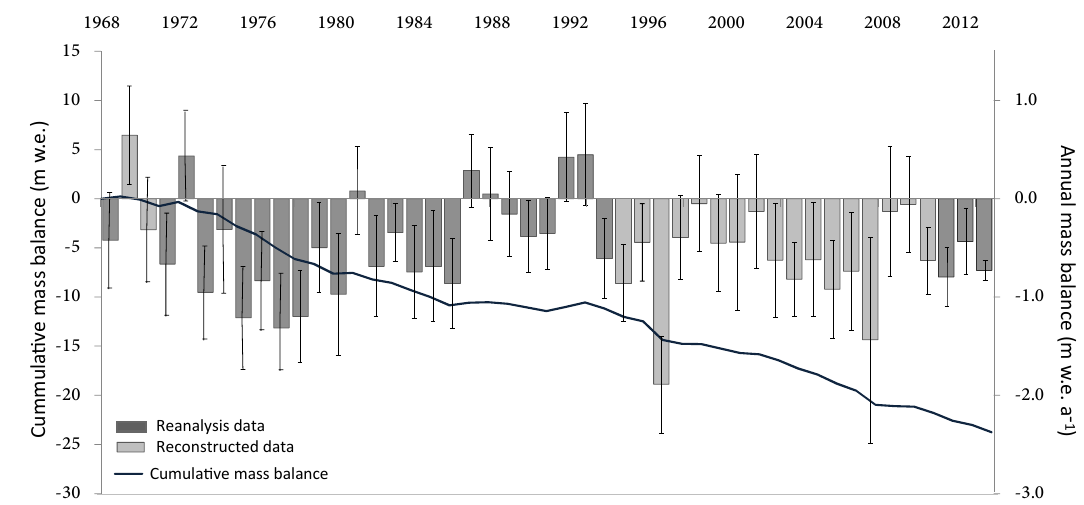
Figure 4. Reconstructed mass balance data for the Abramov glacier according to Barandun et al. (2015). Table 4. Observed geodetic mass balance for Abramov, Golubin, Batysh Sook and Glacier No. 354. B glac.-rec. refers to a study by Barandun et al. (2015), where the mass balance was reconstructed based on a calibrated model (see Sect. 3.3.6). Glacier Method Source Period B a Abramov B glac.-rec. Barandun et al. (2015) − 0 . 51 ± 0 . 15 Abramov B geod. Gardelle et al. (2013) − 0 . 03 ± 0 . 14 Golubin B geod. Golubin B geod. Glacier No. 354 B geod. Pieczonka and Bolch (2015) − 0 . 79 ± 0 . 25 Glacier No. 354 B geod. Kronenberg et al.